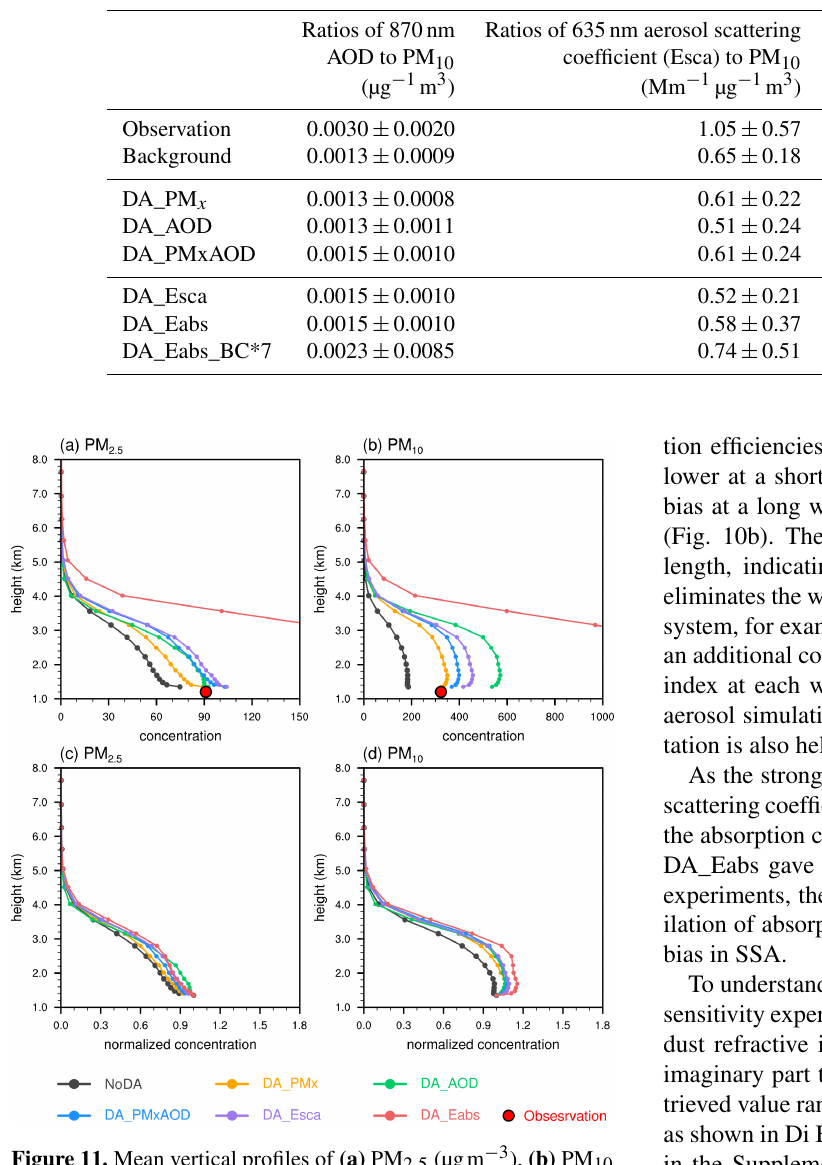
Figure 11. Mean vertical profiles of (a) PM 2 . 5 (µgm − 3 ), (b) PM 10 (µgm − 3 ), and their normalized concentration respect to their own surface concentrations (c, d) at Kashi in April